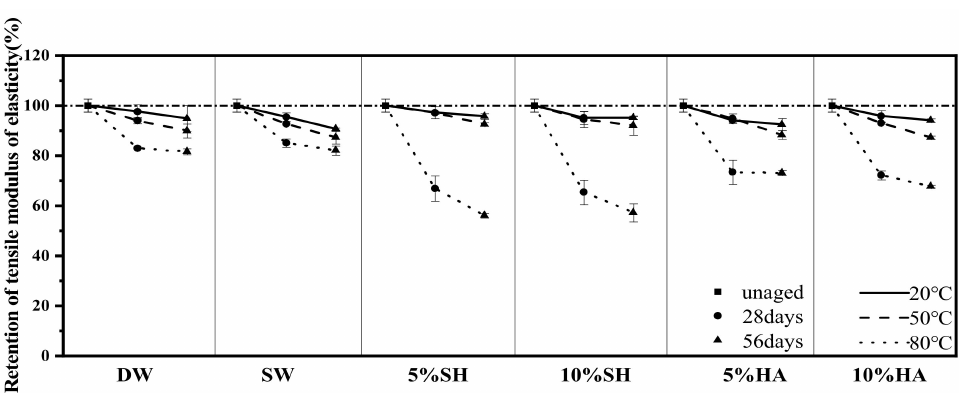
Figure 10. Variation of the residual tensile elastic modulus as a function of immersion time and temperatures in various